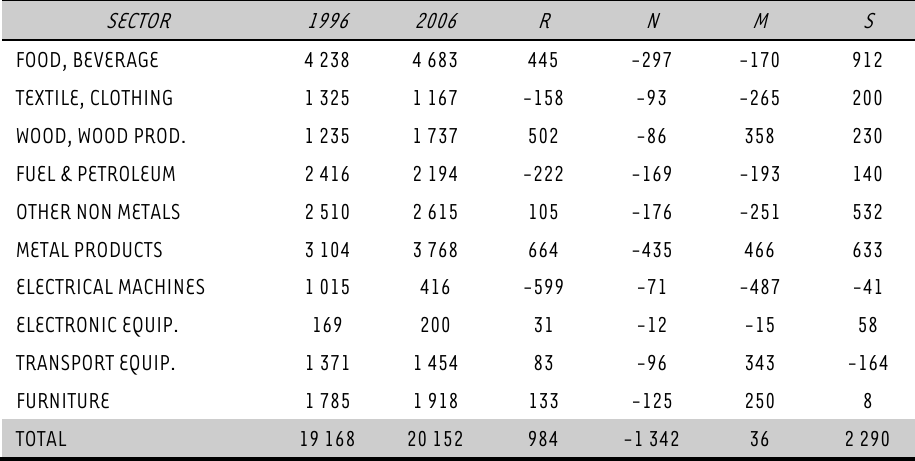
Shift-Share analysis of the Platinum SDI (1996-2006) SECTOR